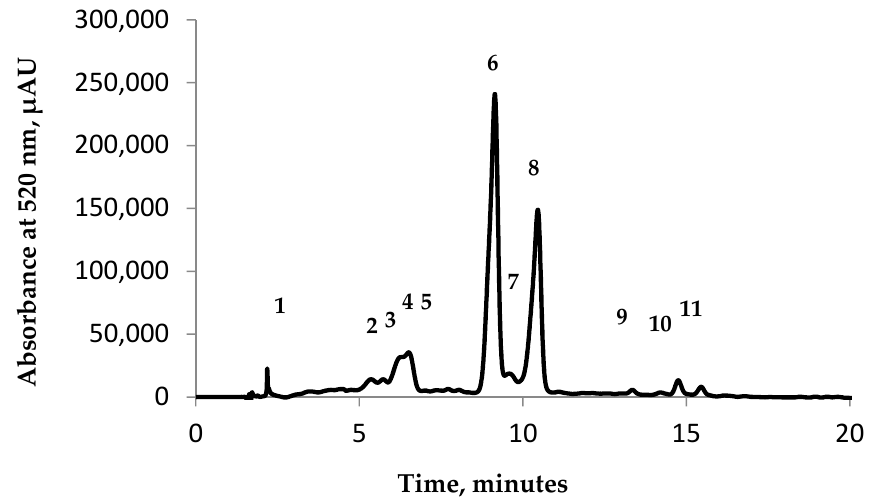
Figure 2. Chromatographic profile of eggplant peel extracts: Peak 1—delphinidin 3- O -rutinoside-5-glucoside; Peak 2—5: unidentified; Peak 6—delphinidin 3- O -glucoside; Peak 7—unidentified; Peak 8—delphinidin 3- O -rutinoside; Peak 9—unidentified; Peak 10—cyanidin 3- O -rutinoside; Peak 11–petunidin 3- O -rutinoside.